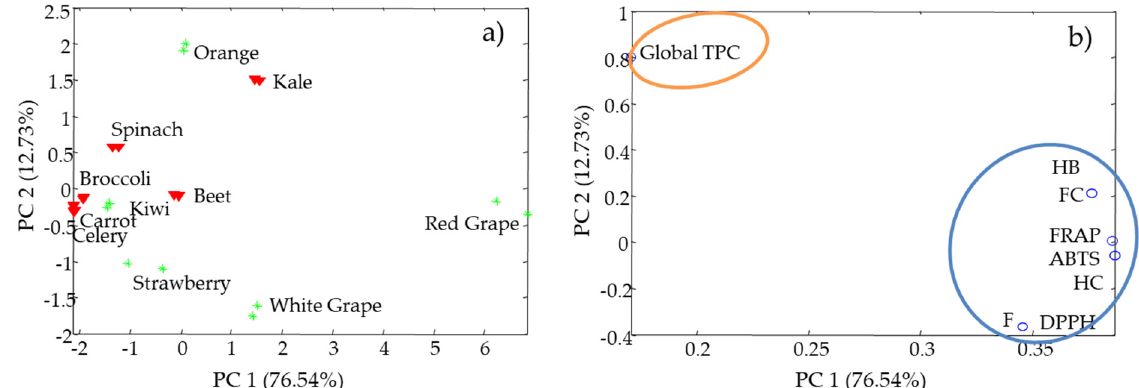
Figure 2. Principal component analysis for the evaluation of the antioxidant features of various fruit and vegetable waste extracts: ( a ) Plot of scores of PC1 vs. PC2 and ( b ) plot of loadings of PC1 vs. PC2. Variable assignation: HB = hydroxybenzoic acids, HC = hydroxycinnamic acids, and F = flavonoids.